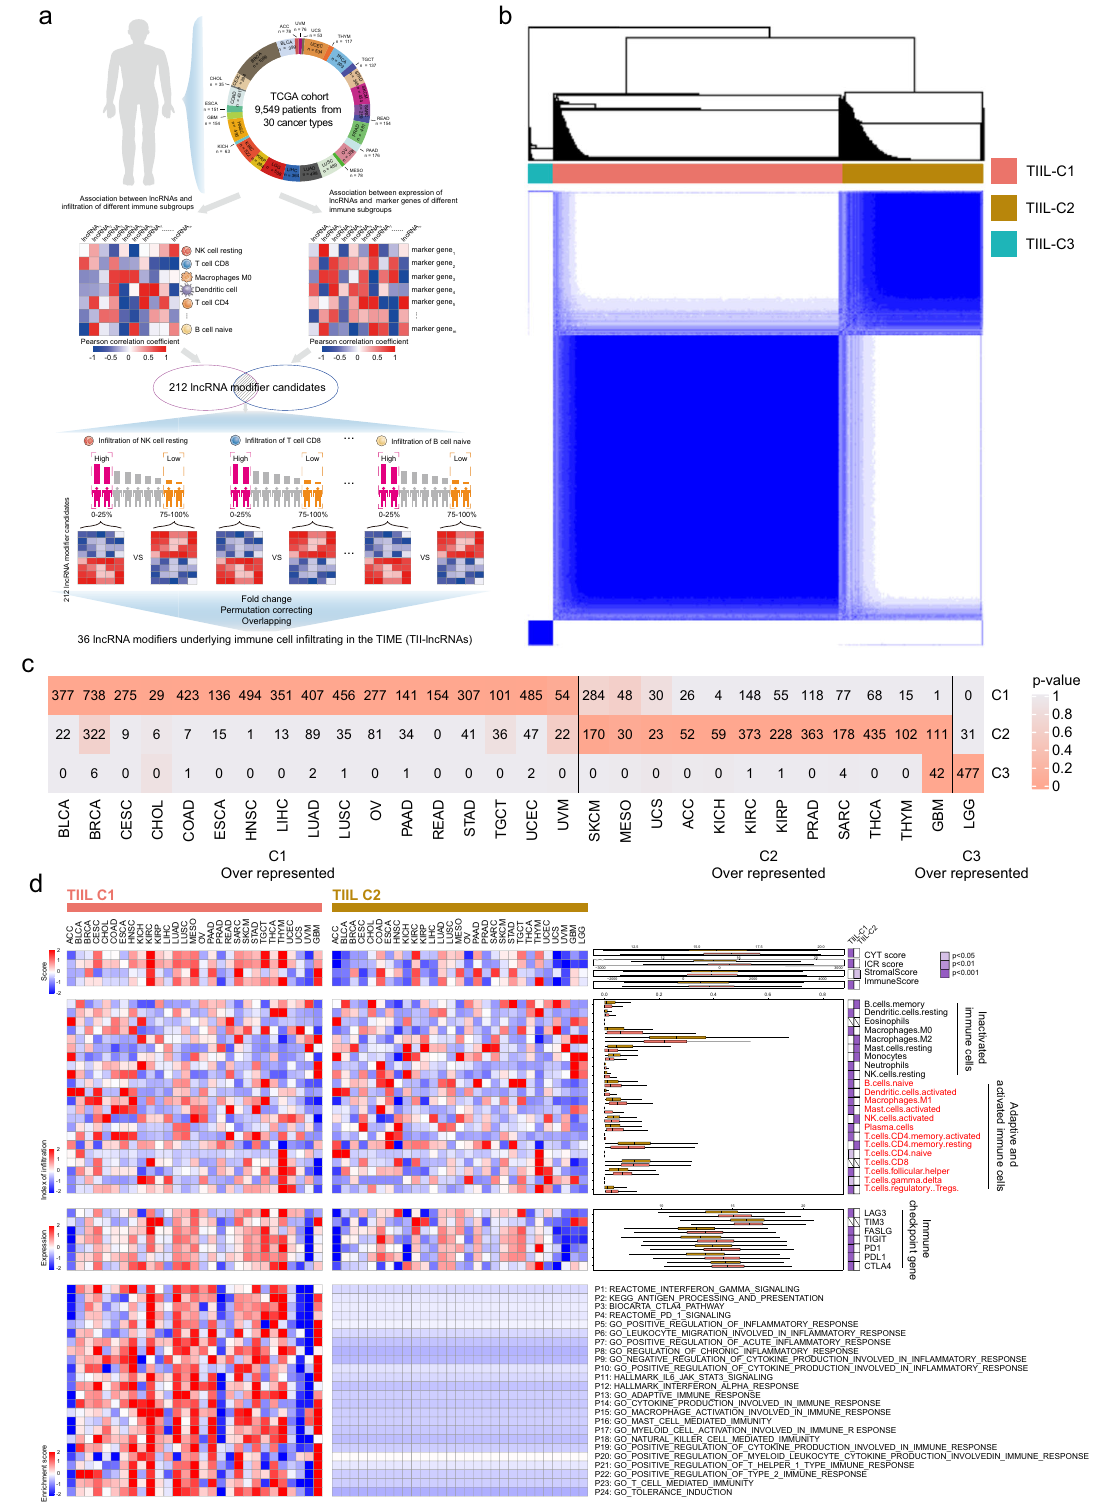
Fig. 1 Derivation of de novo pan-cancer subtypes based on TII-lncRNAs. a Schematic illustration of the systems immunology framework for identifying potential lncRNA modi fi er candidates of in fi ltrating immune cells within the TIME. b Consensus clustering matrix of 9549 TCGA pan-cancer samples based on RNA-seq expression values of 36 TII-lncRNAs. c The number of cases in each cluster across tumor types. Colors in the boxes represent the P -value calculated from a hypergeometric test that compared the proportion of samples with a known cancer type in a cluster to the overall proportion of samples in that cluster. Red represents the enrichment level. d Comparison of immunological features within the TIME between de novo pan-cancer subtypes de fi ned by TII-lncRNAs. lncRNA long noncoding RNAs, TII-lncRNAs TIME lncRNA modi fi ers, TCGA The Cancer Genome